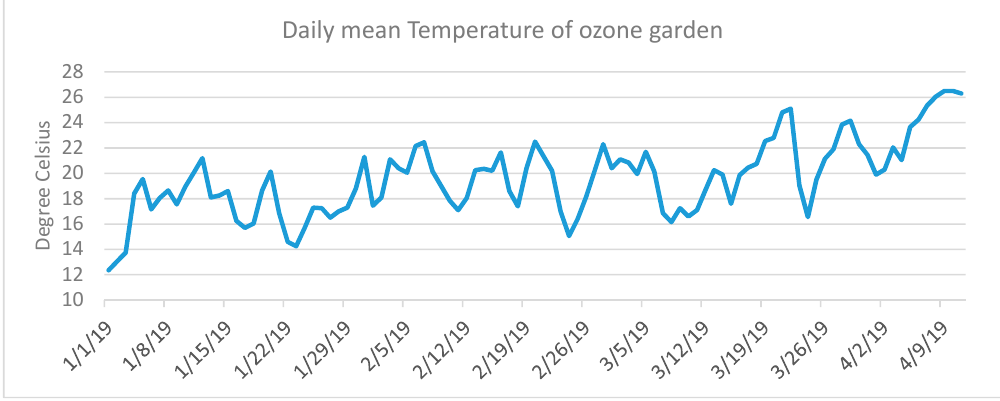
Figure A1. Daily mean temperature recorded at the Ozone Garden (latitude 22.4248°, longitude 114.2068°) from 1 January to 10 April 2019. Atmosphere 2019 , 10 , x FOR PEER REVIEW Table A1. Relative humidity and total rainfall of the growing period in 2019 recorded at the Ozone Garden (latitude 22.4248°, longitude 114.2068°).